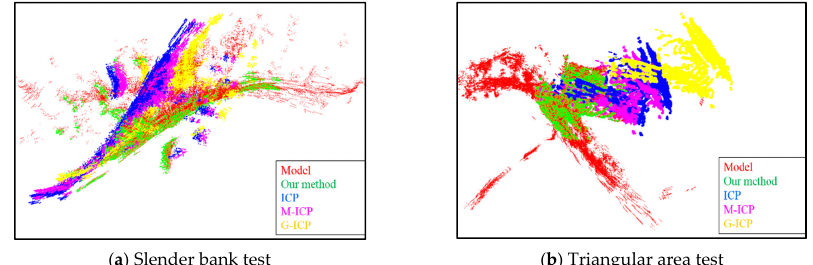
Figure 10. Registration results of the abrupt turn test. In the slender bank test, the translation error was [15, 14, 20], and the rotation error was [17 ˝ , 20 ˝ , 190 ˝ ], our proposed method make the registration with the RMS error at 1.5 m and rotation error at 2.3 ˝ . In the triangular area test, the translation error was [14, 15, 20], and the rotation error was [10 ˝ , 20 ˝ , 171 ˝ ], our proposed method guarantee the registration result with the RMS error at 2.3 m and rotation error at 1.7 ˝ .